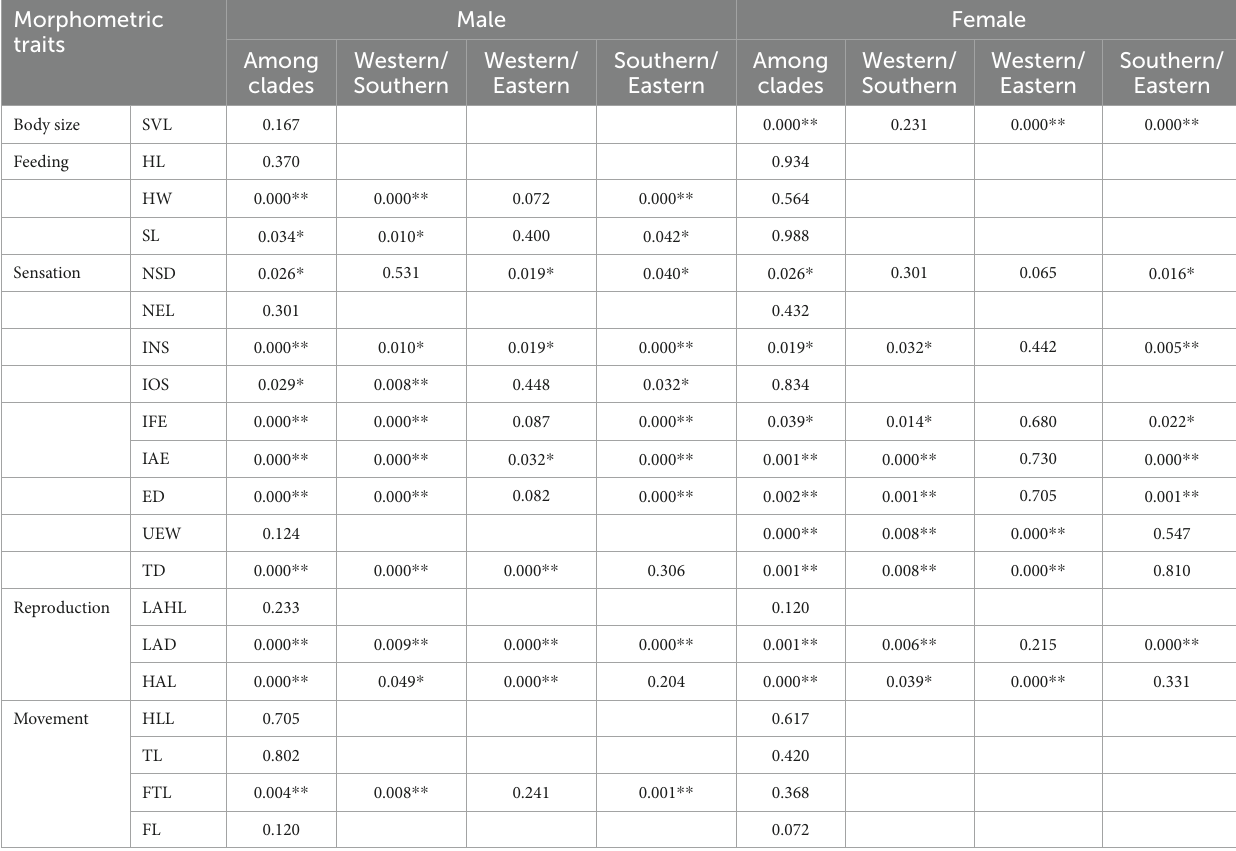
TABLE 3 Kruskal–Wallis analysis based on 20 morphometric traits between clades of Odorrana graminea sensu stricto. Morphometric traits